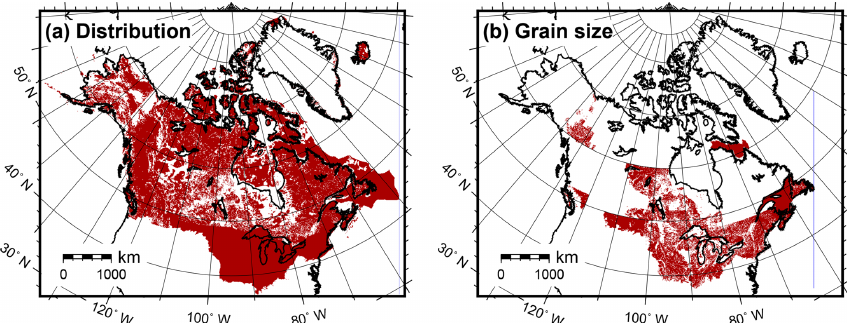
Figure 2. Data coverage (brown areas) derived directly from surficial geology maps. (a) Sediment distribution and (b) sediment grain